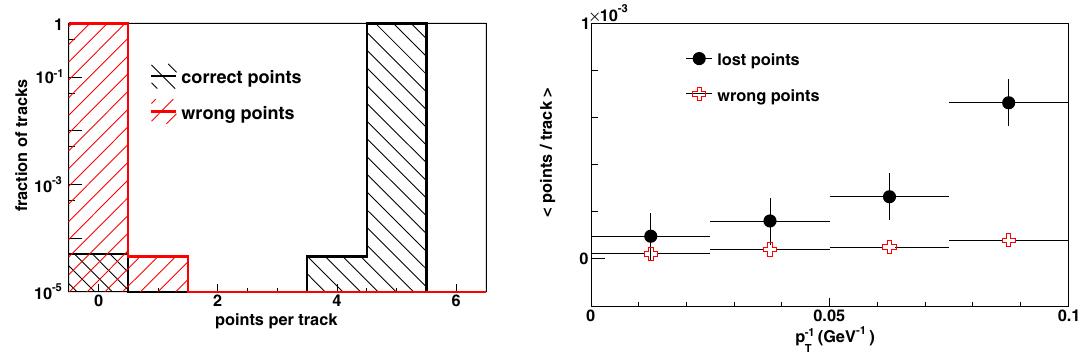
Figure 12. The number of correctly and wrongly assigned hits per track for signal particles with p T > 10 GeV, shown (left) inclusively and (right) as a function of true p − 1 T